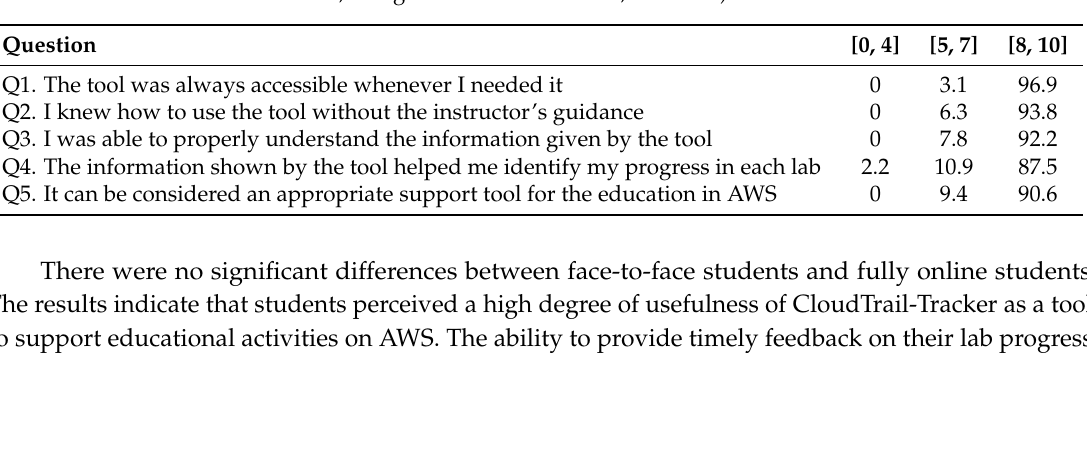
Table 1. Results of the satisfaction questionnaire with CloudTrail-Tracker (the percentage of students that answered in each interval, using a 10-item Likert scale, is